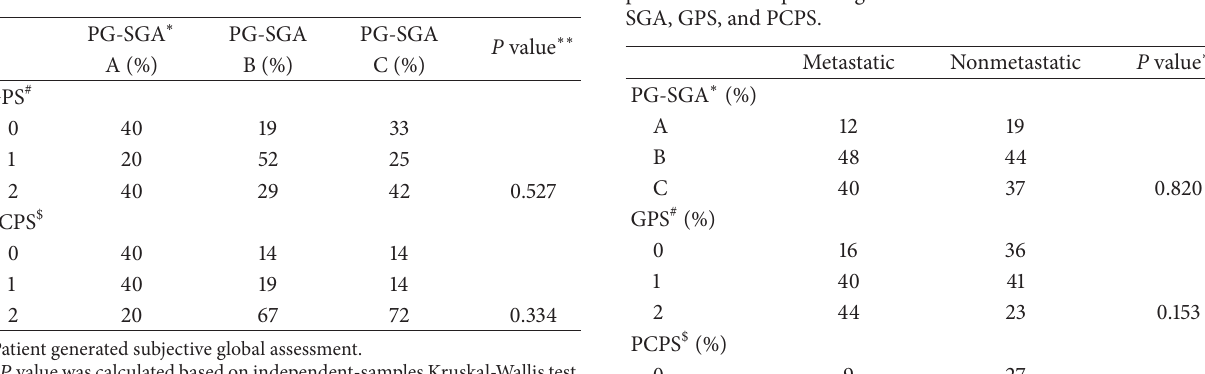
Table 5: The association between GPS, PCPS, and categorized PG- SGA.